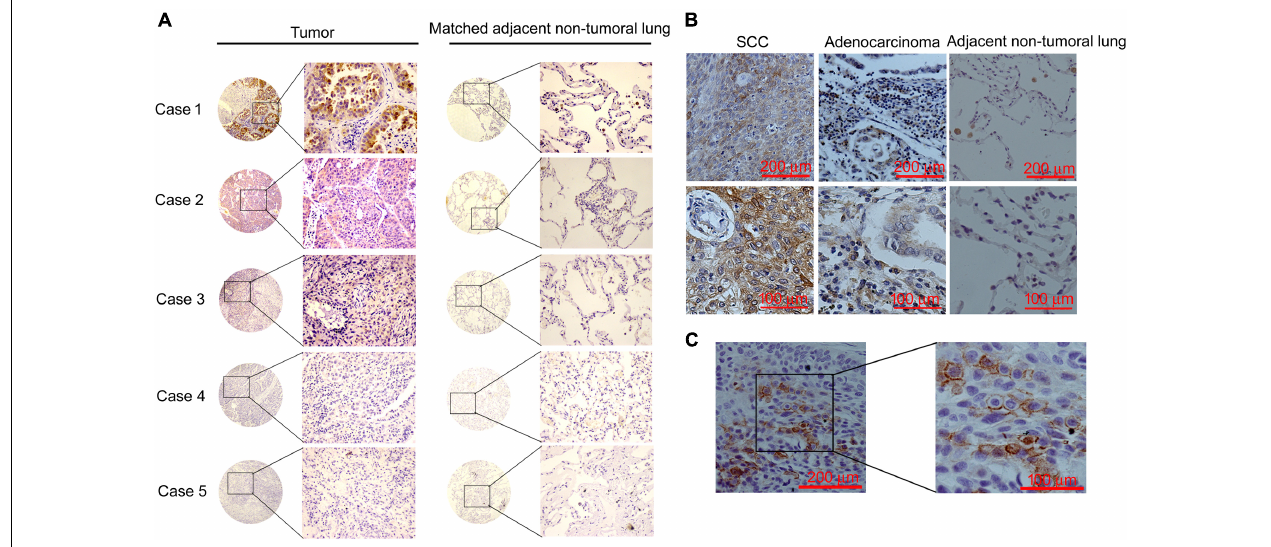
FIGURE 2 | CCNY were highly expressed in NSCLC tissues. Immunohistochemical staining of CCNY. (A) IHC assay detecting the level of CCNY in lung cancer tissue and the paired non-tumoral lung from the TMA. CCNY was mainly localized in the cytoplasm, whereas the non-tumoral lung tissues were negative. Case 1, adenocarcinoma; case 2, squamous cell carcinoma (SCC); case 3, adenocarcinoma-SCC; case 4, large-cell carcinoma; case 5, bronchioloalveolar carcinoma (BAC). The magnification of images in circles is × 40; the magnification of images in rectangles is × 100. (B) Immunohistochemical examination of CCNY protein in primary NSCLC tissue and the matched non-tumoral lung tissues. Upper panel with an original magnification of × 100; lower panel with an original magnification of × 400. (C) IHC examination of CCNY protein in primary NSCLC tissue. CCNY was mainly distributed in the cell membrane. Original magnification, right panel, × 400; left panel, ×